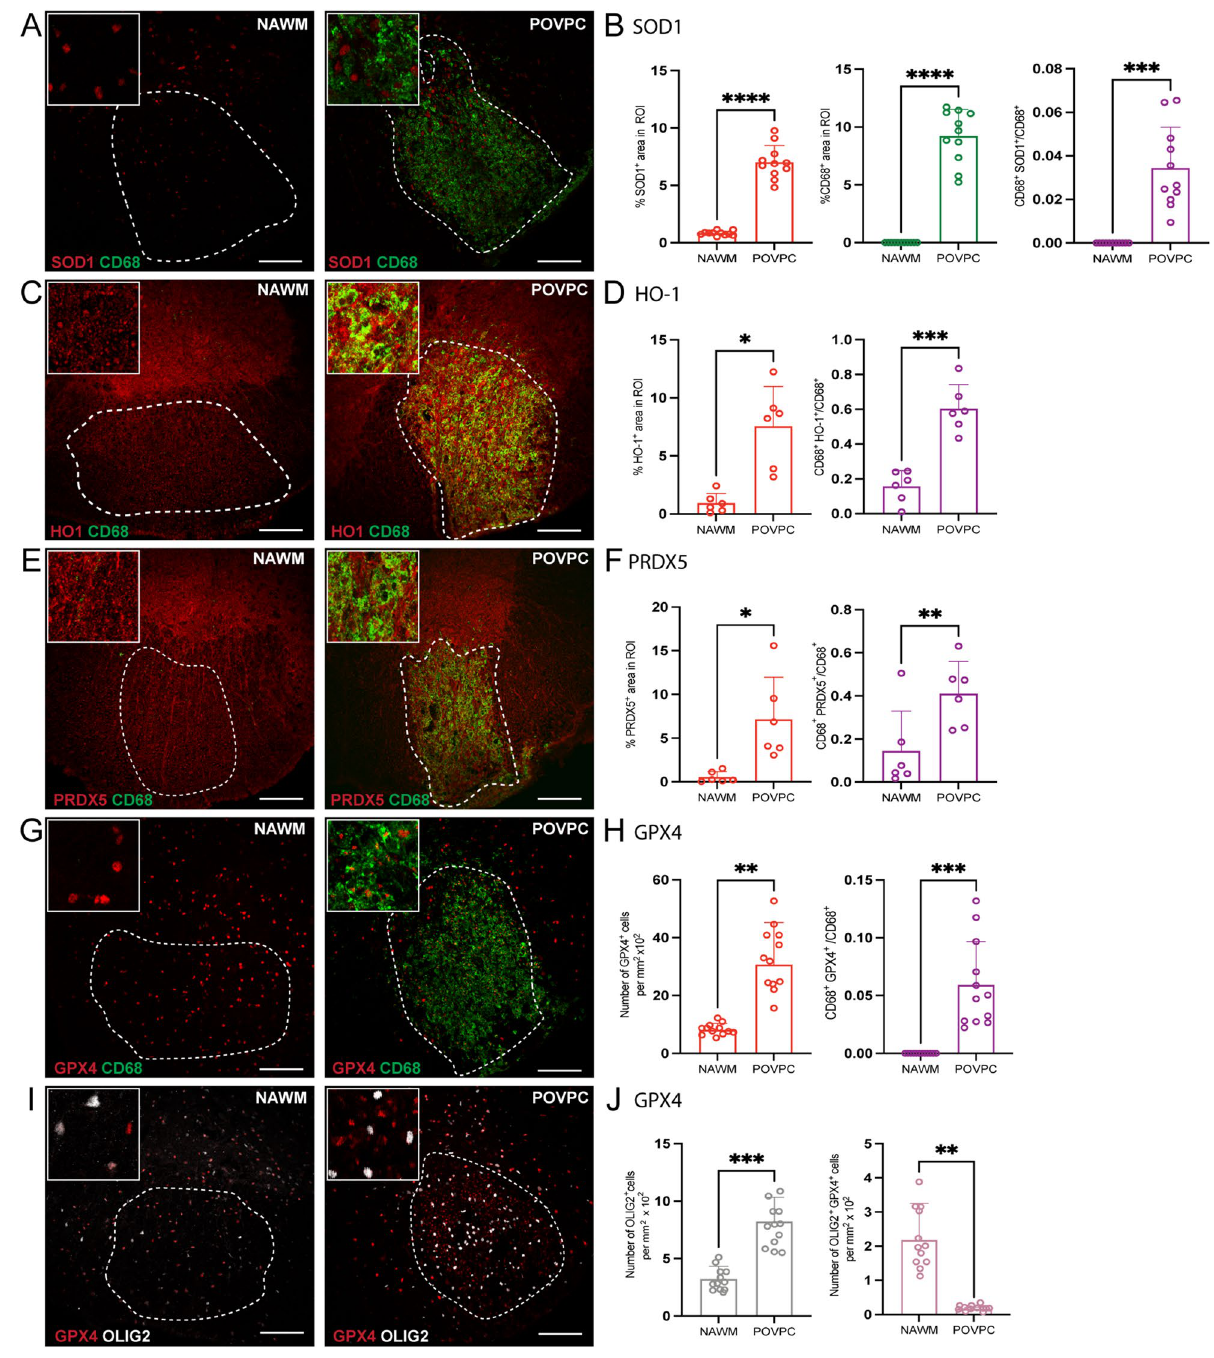
Figure 2. Expression of antioxidant enzymes is upregulated in POVPC-induced spinal cord lesions. ( A , C , E , G , I ) Representative confocal images of NAWM or POVPC injected spinal cord labeled with CD68 for microglia/ macrophage (green), antioxidant enzyme of interest (red), and OLIG2 for oligodendrocyte lineage cells (white). Dotted line indicates the NAWM or lesion region of interest (ROI) selected for image analysis. ( B , D , F ) Bar graphs comparing the percent of ROI that is CD68 + , antioxidant enzyme of interest, and CD68 + antioxidant enzyme + . ( H ) Bar graph comparing the number of GPX4 + cells per mm 2 × 10 2 of ROI and percent of ROI that is CD68 + GPX4 + ( J ) Bar graph representing number of OLIG2 + cells per mm 2 × 10 2 of ROI and percent of ROI that is OLIG2 + GPX4 + . Scale bar = 100 µm. Data are shown as mean ± S.D, n = 6–12 mice. Significance indicated as * p < 0.05, ** p < 0.01, *** p < 0.001, **** p < 0.0001, two-tailed, paired student’s